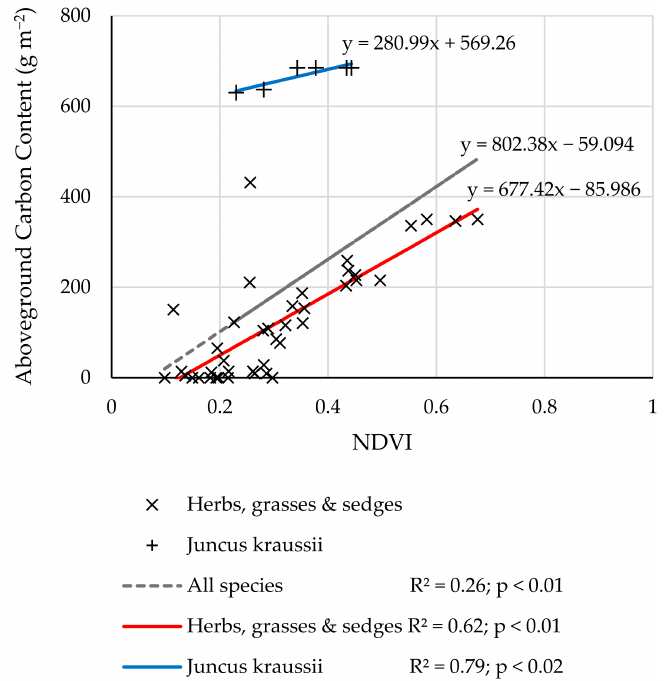
Figure 4. Simple linear regression model between NDVI derived from the ArborCam image (bands four and seven) with aboveground carbon content for all 47 quadrats, and quadrats partitioned into two groups: herbs, grasses, and sedges (41 quadrats), and J. kraussii (6 quadrats).